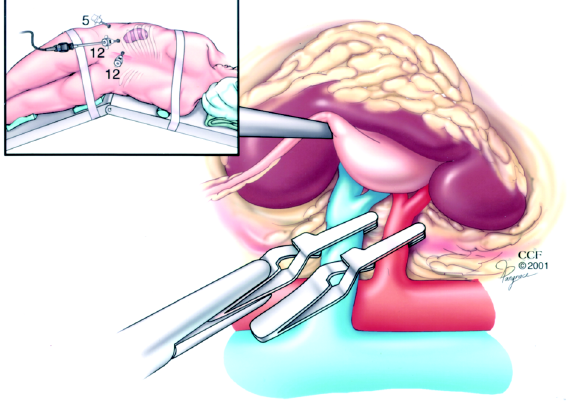
Figure 4 – Retroperitoneal laparoscopic partial nephrectomy. Because of limited operative space, 2 laparoscopic bulldog clamps are used for individual control of the mobilized renal artery and vein, respectively. Inset shows 3-port retroperitoneal approach. Adapted from reference 10. (Reprinted with the per- mission of the Cleveland Clinic